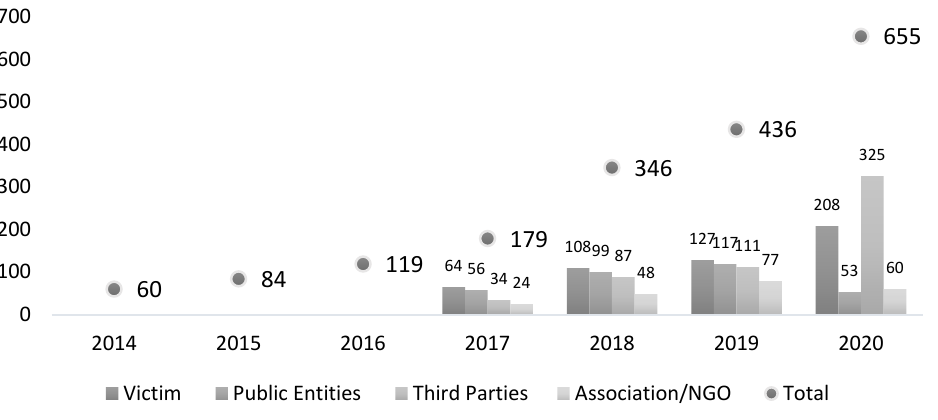
Figure 1. Evolution of participation, complaints or denunciations received by the CICDR ( n )—2014